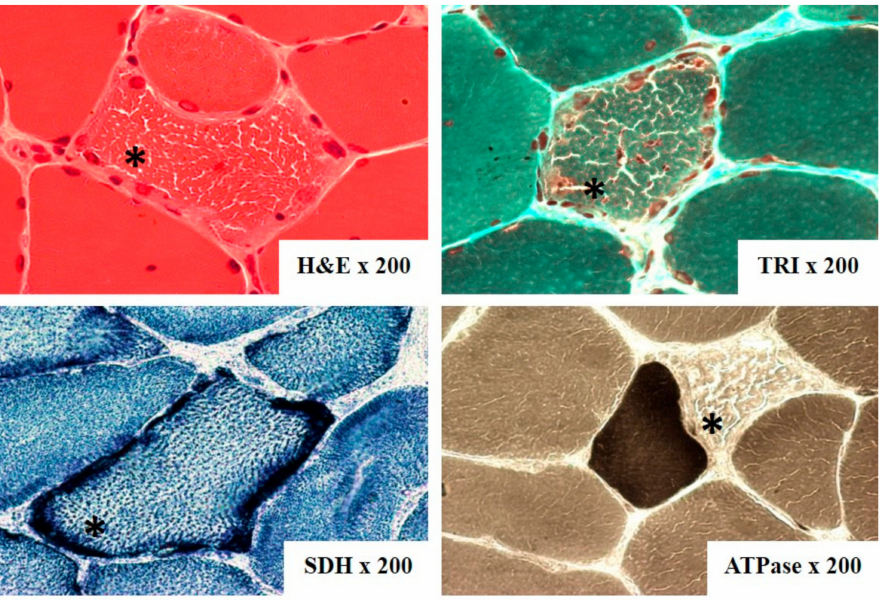
Figure 4. Ragged-red fibers (*) on skeletal muscle biopsy from patient with CPEO+ (patient number 45), (H&E— hematoxylin&eosin, TRI—Gomori trichrome, ATPase—adenosine triphosphatase pH 9.4, SDH—succinic